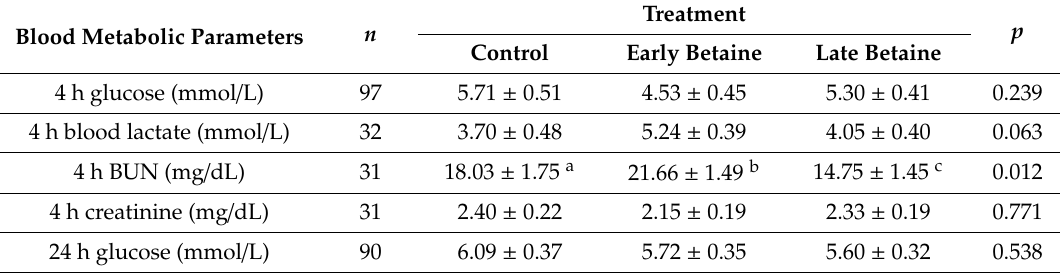
Table 5. Lamb plasma glucose and 4 h blood lactate, blood urea nitrogen (BUN) and